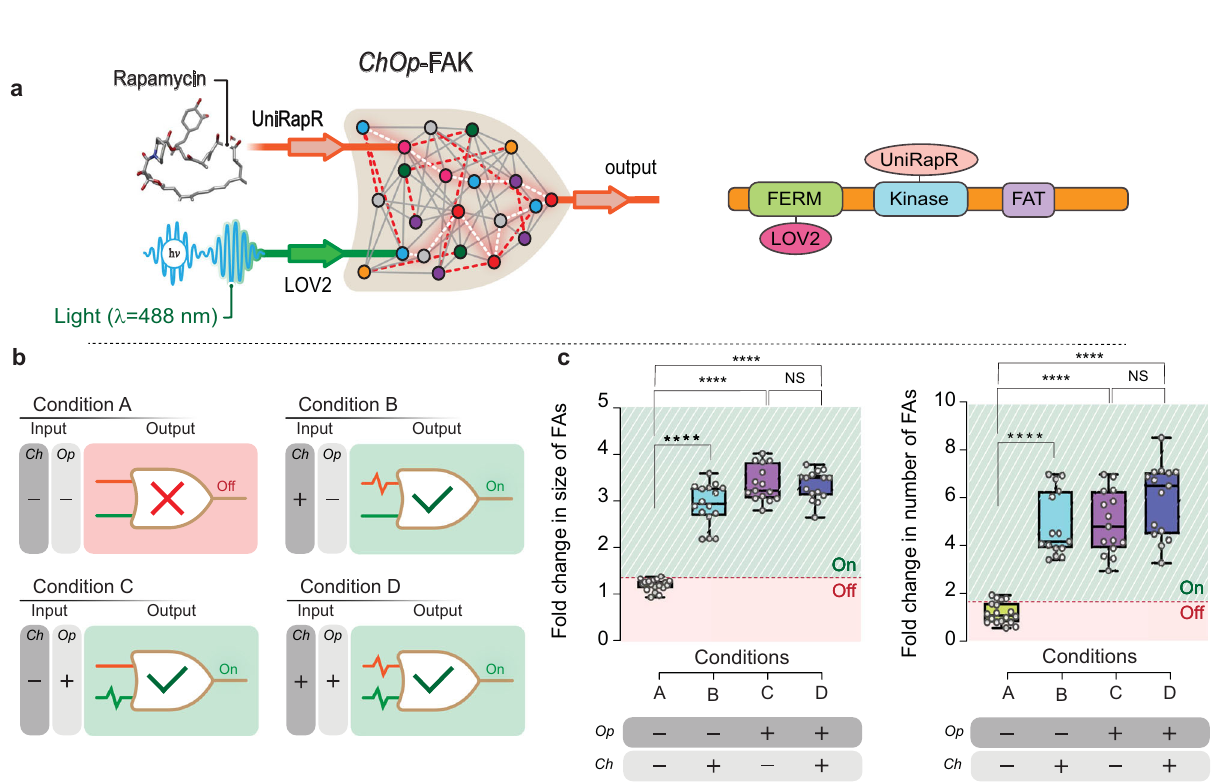
Fig. 6 Activation of Op -FAK expressed in FAK − / − cells is light sensitive. a Schematic representation of the Op -FAK. LOV2 domain is inserted into the FERM domain of FAK. Light is used as input signal. Dark condition activates FAK and light conditions inactivates FAK. b Images of cells transfected with Op -dark-FAK (left) and Op -lit-FAK (right) on a fi bronectin-coated glass surface. Inset shows the cell edges with arrows highlighting focal adhesions. Scale bar, 40 μ m. c Normalized quanti fi cation of average size and total number of focal adhesions in Op -dark-FAK- and Op -lit-FAK-expressing FAK − / − cells on a fi bronectin-coated glass surface. Data represent bar plots with mean±s.d. and individual data points, n = 10 cells for dark and lit mutants from 3 independent experiments; **** P = 6.2 × 10 − 11 for number of focal adhesion (FAs), ** P = 0.0014 for size of FAs in mutants calculated by unpaired two-tailed Student ’ s t -test. NS, not signi fi cant. d Images of Op -lit-FAK- (left) and Op -dark-FAK-expressing (right) FAK − / − cells on PAA gels printed with fl uorescently labeled fi bronectin grids. Zoomed-in images show the well-formed focal adhesions along the grid lines for Op -dark-FAK. Scale bar, 40 μ m; zoomed-in images, 14 μ m. e Top, time-lapse images of FAK − / − fi broblasts that express Op -FAK exposed to light for the indicated periods of time. Bottom, magni fi cation of region boxed in the upper left panel as a function of time in response to blue light (488 nm). Arrows indicate focal adhesions. Scale bar, 40 μ m. f Normalized quanti fi cation of average size and total number of focal adhesions during light-induced inactivation of FAK − / − cells that express Op - FAK or Op -dark-FAK (control). FAs indicates focal adhesions. Data represent box plots and individual data points. Box plots show the median (center line), fi rst and third quartiles (box edges), while the whiskers going from each quartile to the minimum or maximum. n = 10 cells for total FAs and average size of FAs from 3 independent experiments; *** P = 0.0003 for number of FAs, *** P = 0.0001 for size of FAs in Op -FAK. P = 0.7737 for number of FAs and P = 0.4617 for FAs size in control conditions calculated by unpaired two-tailed Student ’ s t -test. NS, not signi fi cant. Source data are provided as a Source Data fi le.